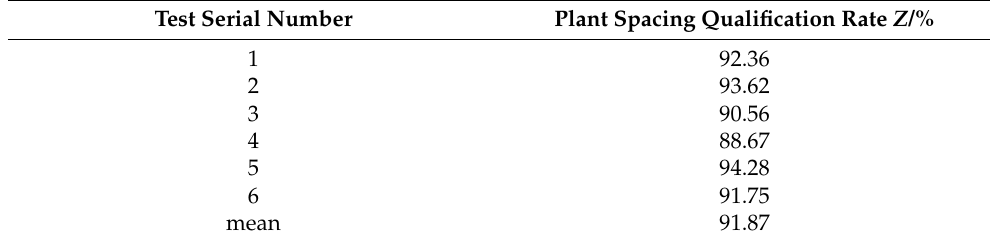
Figure 9. Field experiment results: ( a ) field experiment; ( b ) experiment result; ( c ) effect of horizontal planting. Table 5. Results of the field